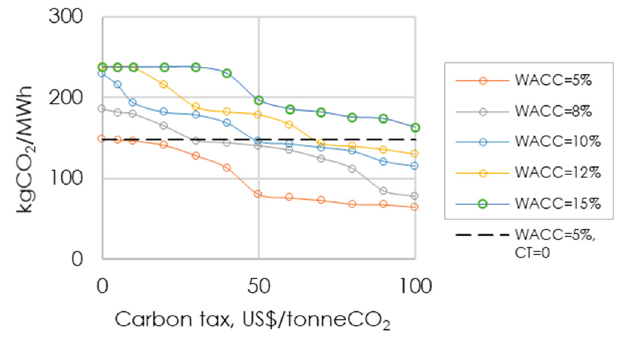
Figure 9. Average multiyear carbon intensity vs. carbon tax for five WACC scenarios.